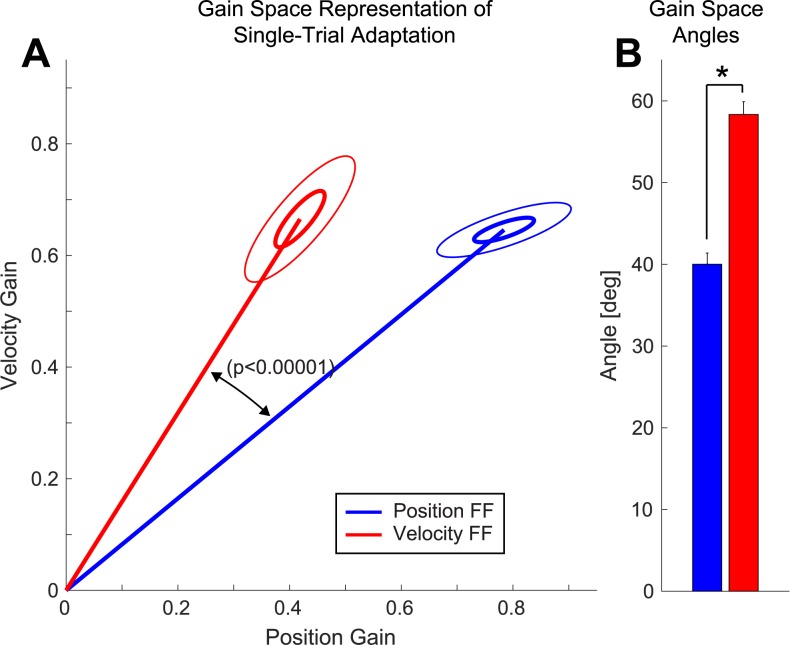
Gain-space representation of velocity and position contributions to lateral force for single trial learning.(A) Gain space representations for single-trial pFF (blue) and vFF (red) adaptation. Ellipses represent 1-SEM (inner) and 95% confidence interval (outer) error bars in the position-velocity (PV) gain-space. (B) Average angle in PV gain space for single-trial pFF and vFF adaptive responses. Symbols represent a significant difference in PV gain-space angles between pFF and vFF adaptations (p < 0.01, two-tailed t-test). Error bars show SEM.